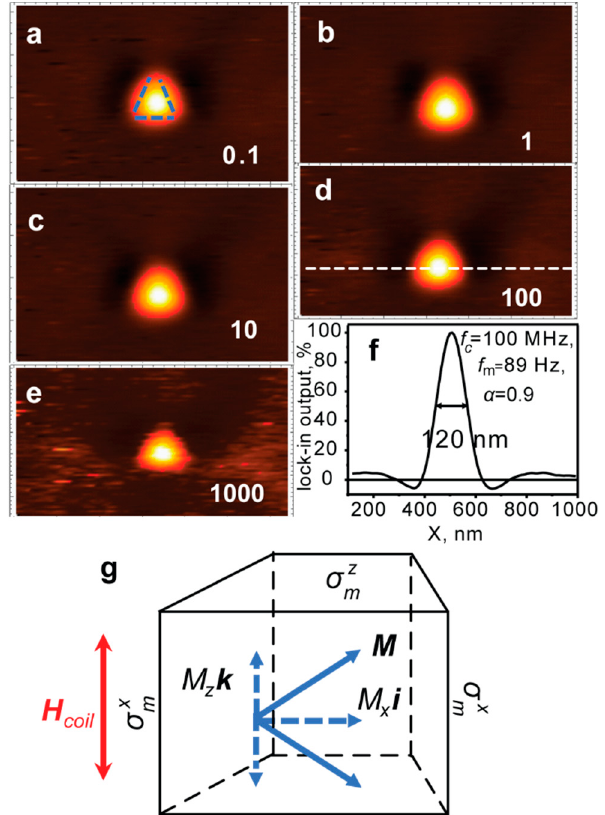
Figure 3. Normalized A-MFM image of the out-of-plane signal near the main pole for f c = 0.1 ( a ), 1 ( b ), 10 ( c ), 100 ( d ) and 1000 ( e ) MHz currents with amplitude modulation at f m = 89 Hz. The horizontal dimension of the images is 1 µ m. The topographical shape of the pole is marked with blue lines. ( f ) Line profile (white line in ( d )) for f c = 100 MHz. ( g ) Schematic model for the XZ cross-section of the main pole with magnetization vector M, its projections, and charge density σ .